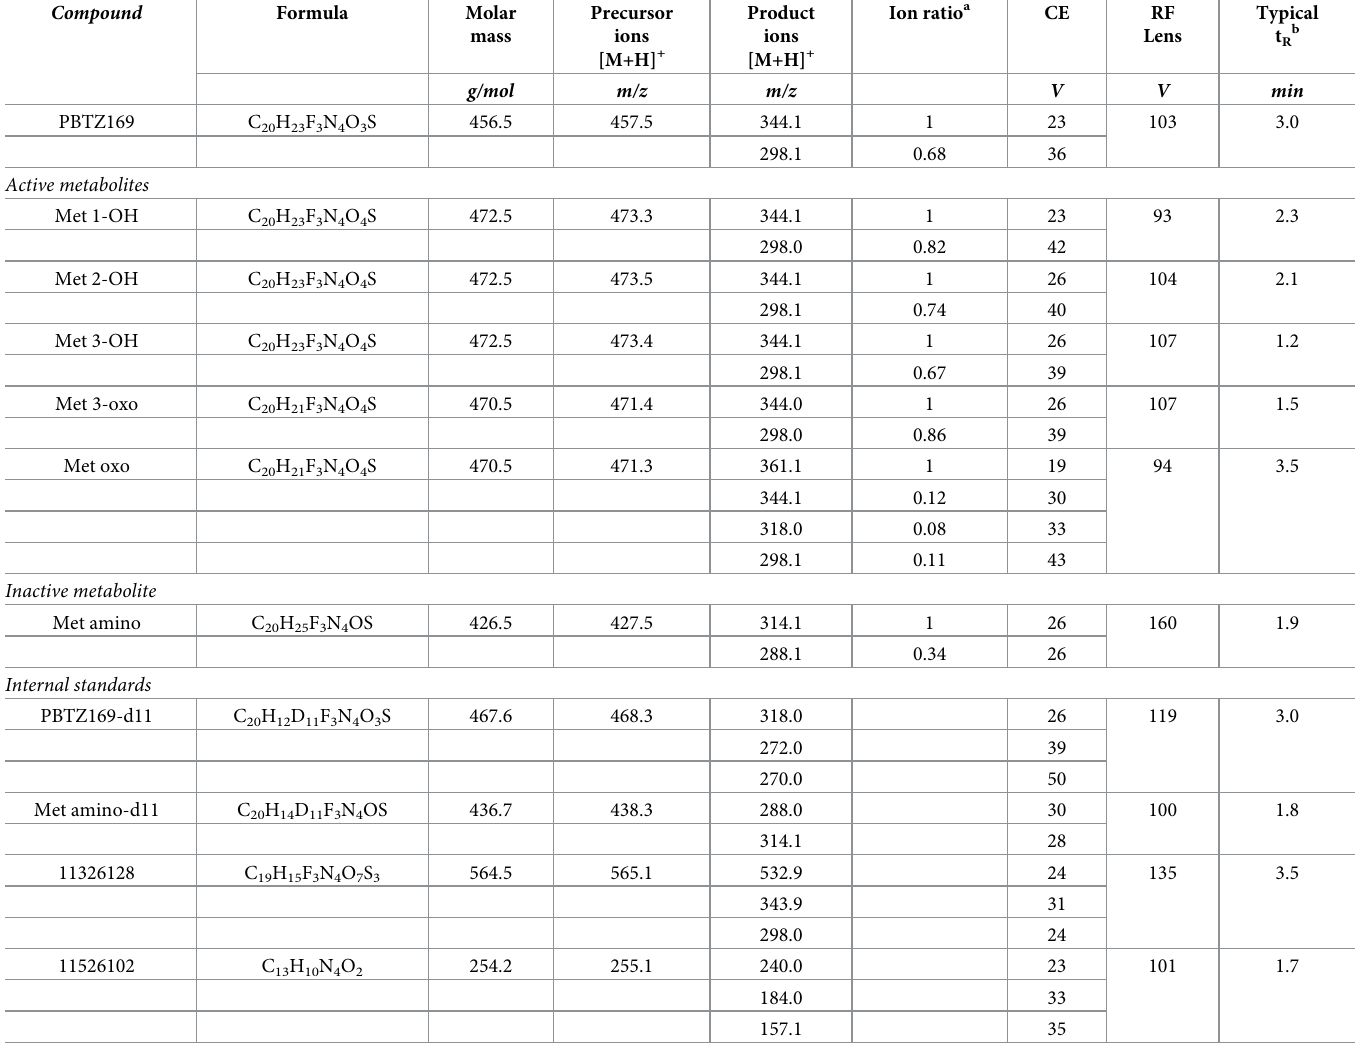
a Calculations are based on peak area and report the mean of ion ratios measured in calibration levels. Peak identity is confirmed when ion ratio is within ± 20% in real human sample. b Minor changes in retention times are possible, in particular for compounds eluted